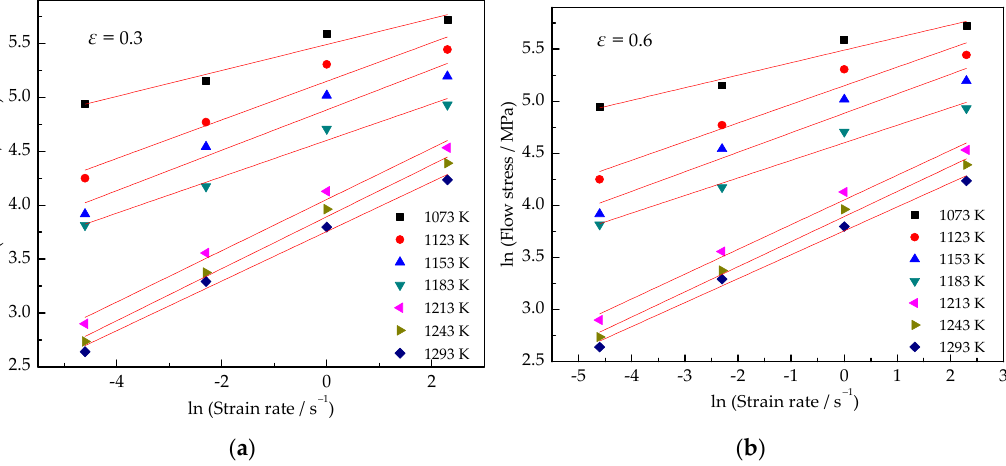
Figure 6. Relationship between ln (strain rate) and ln (flow stress) at strains of ( a ) 0.3 and ( b ) 0.6.